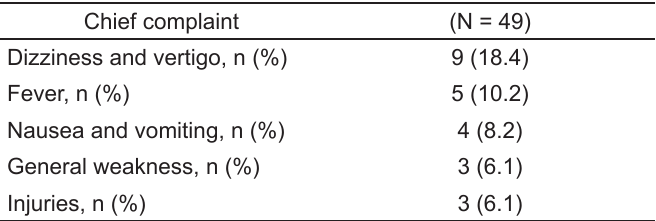
Table 4. The most common chief complaints in the vague-pain